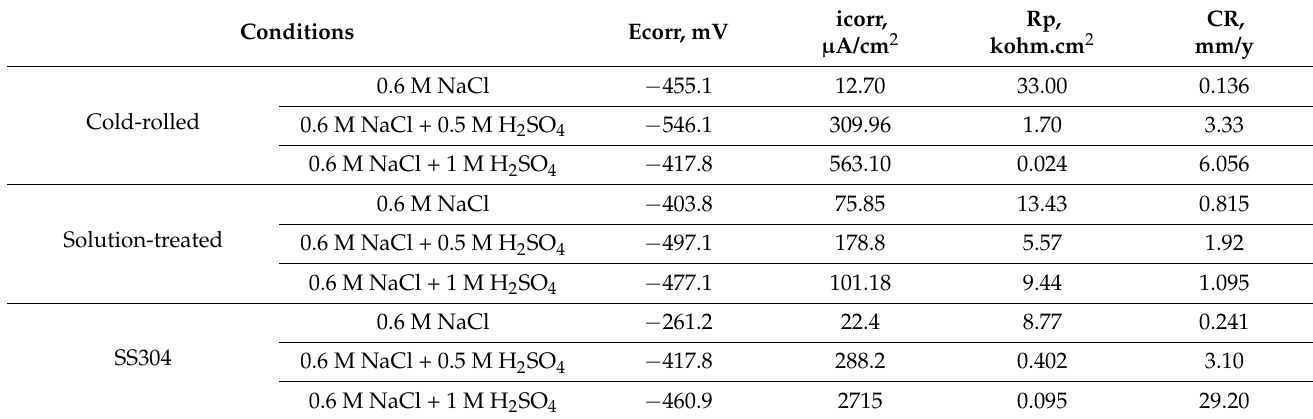
Table 1. The electrochemical parameters of cold-rolled HEA, solution-treated HEA, and